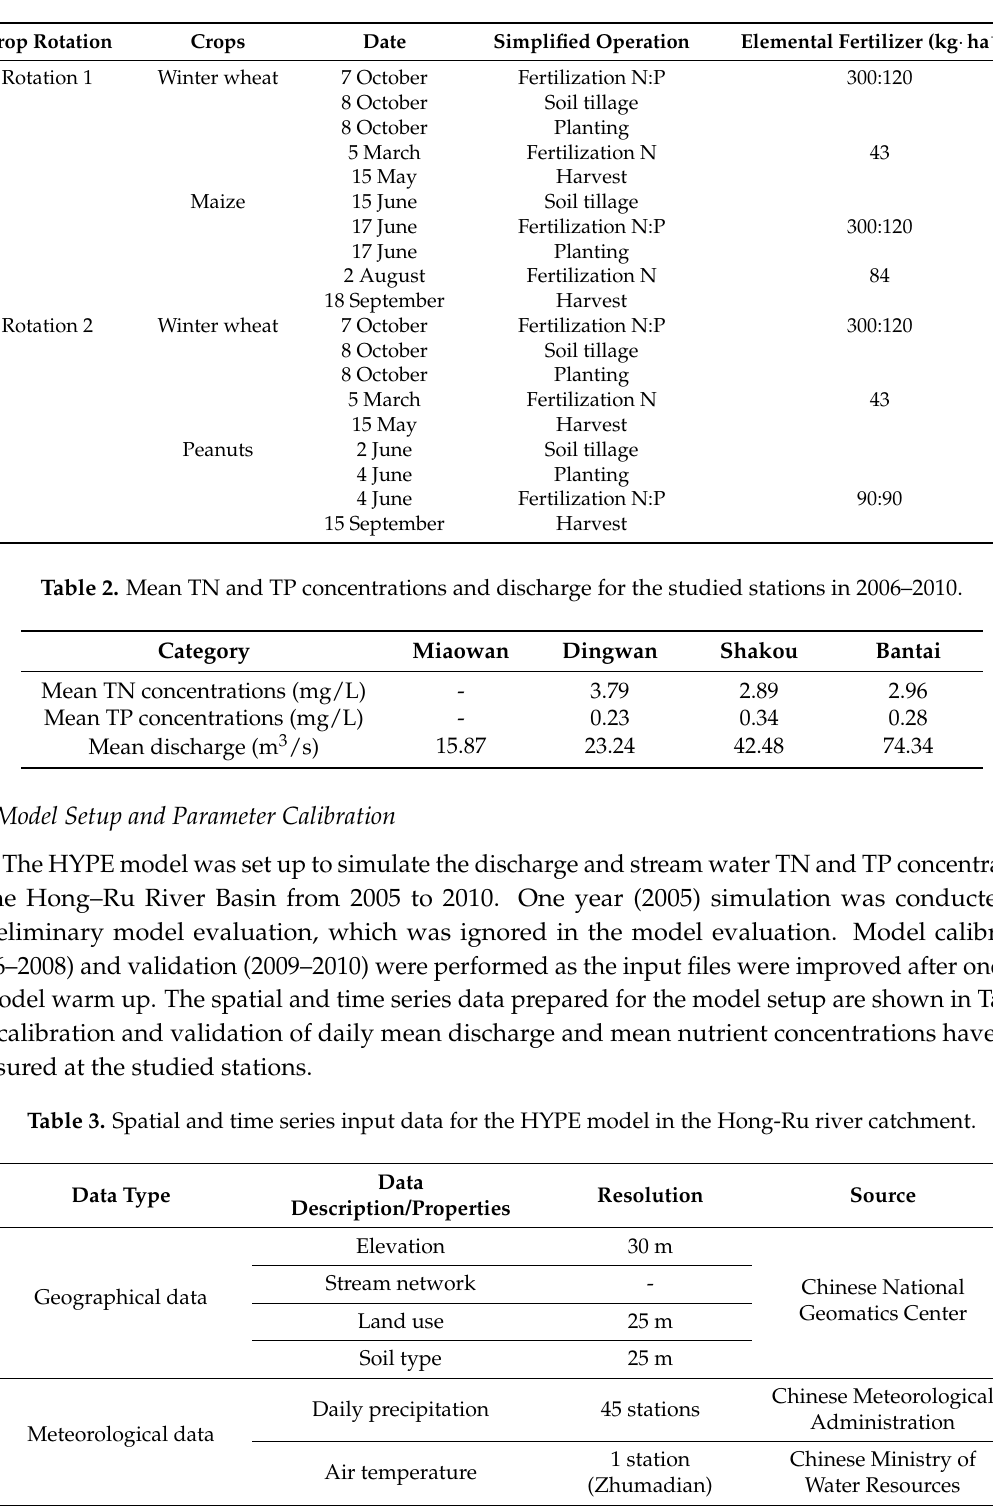
Table 1. Crop rotations and fertilizer applications.